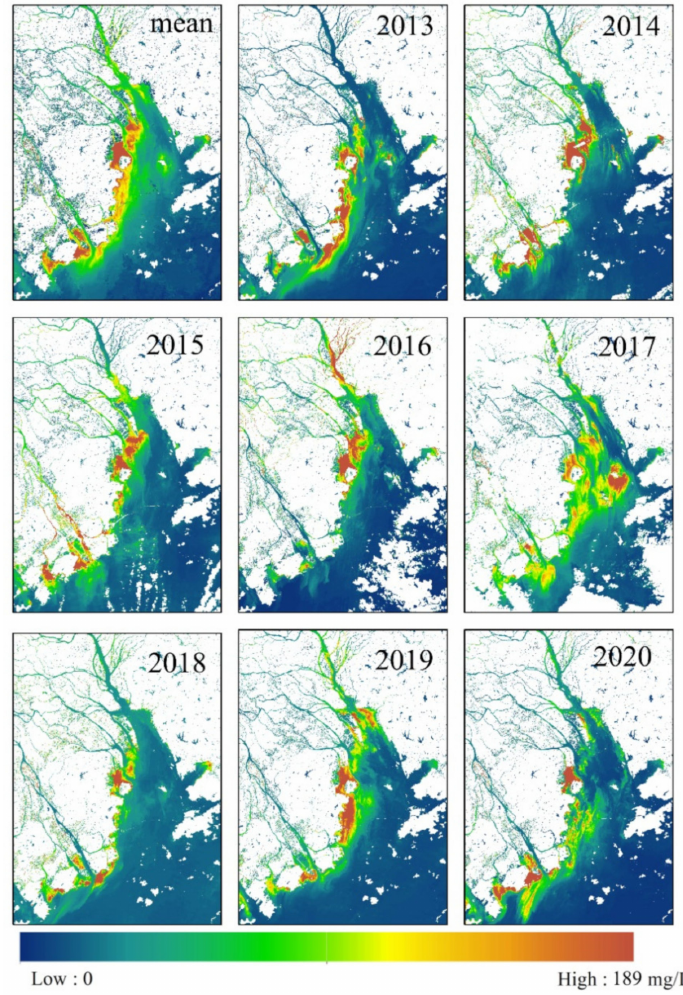
Figure 10. Annual SSC distribution for the years 2013–2020 based on Landsat-8 images. The mean map is the average of the 8-year SSC